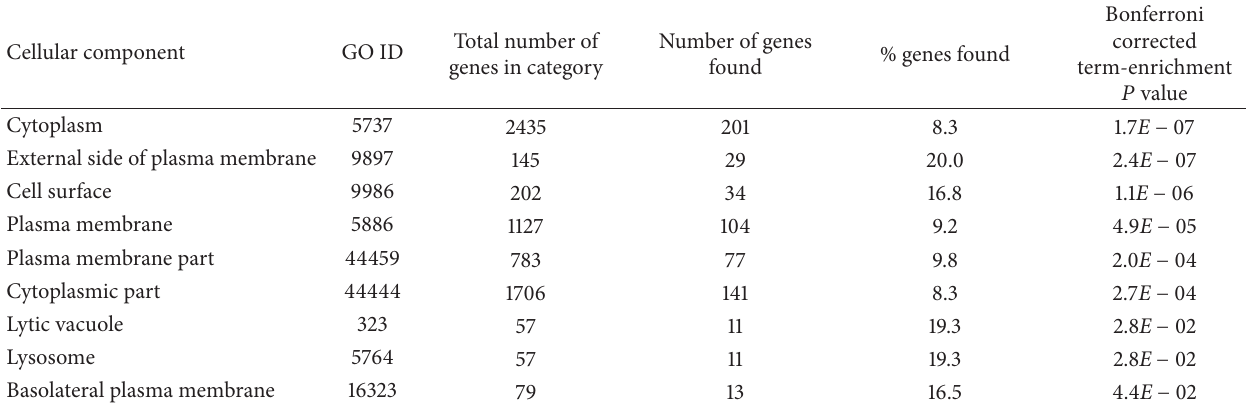
Table 2: Gene ontology analysis of 1607 regulated transcripts in CD8 − lung